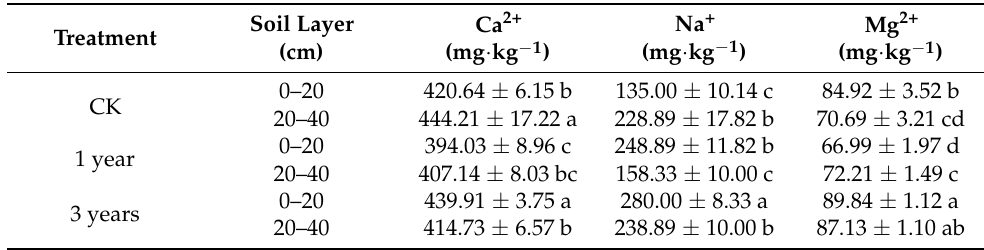
Table 2. Effects of returning shoots on the content of exchangeable cations (mean ± SD). Different lowercase letters in the same figure indicate significant differences at the 0.05 level.